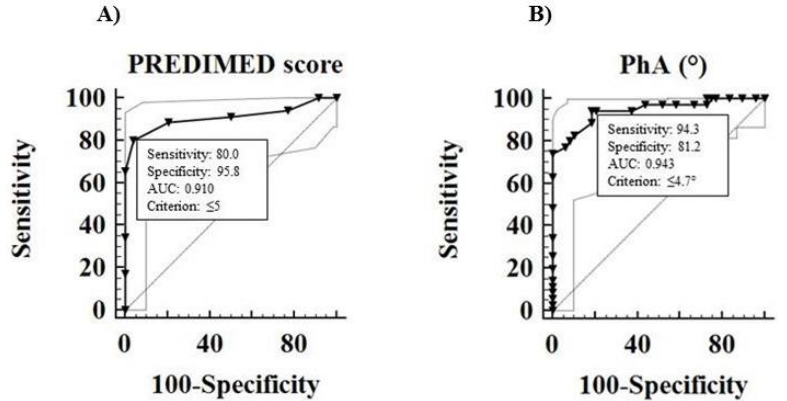
Figure 3. ROC analysis was performed to determine the cut off values of the PREDIMED score ( A ) Figure 3. Receiver operator characteristic (ROC) analysis for the evaluation of increased risk of and PhA ( B ) predictive for the evaluation of increased risk of grading G2. Abbreviation : grading G2. Abbreviation : PREDIMED, PREvención con DIeta MEDiterránea; PhA, phase angle.